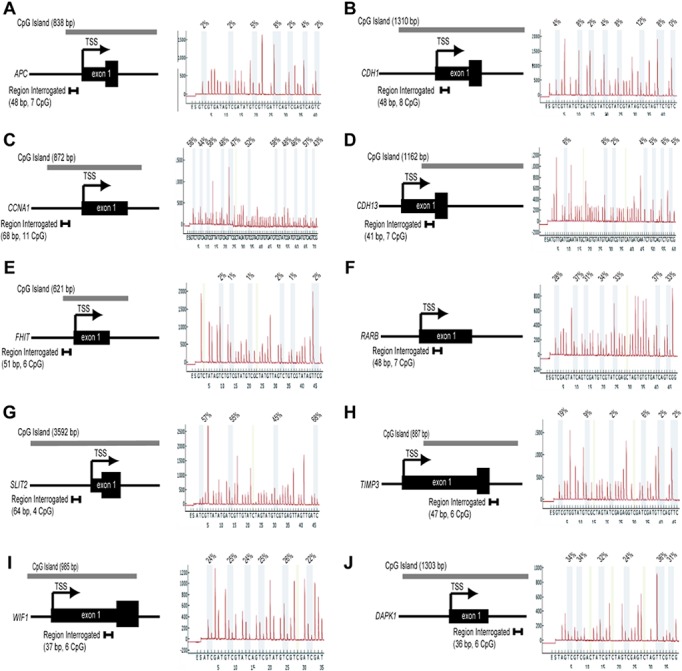
Genes analyzed by Pyrosequencing.Illustrated is the genomic architecture of each locus examined in this study. Included is the relative location of exon 1, the transcriptional start site (TSS), associated CpG island, and the region assayed for methylation by pyrosequencing. Also shown is a representative pyrogram and measured cytosine methylation at each CpG dinucleotide analyzed in the designed pyrosequencing assay. Genes analyzed are APC (A), CDH1 (B), CCNA (C), CDH13 (D), FHIT (E); RARB (F); SLIT2 (G); TIMP3 (H); WIF1 (I) and DAPK1 (J).